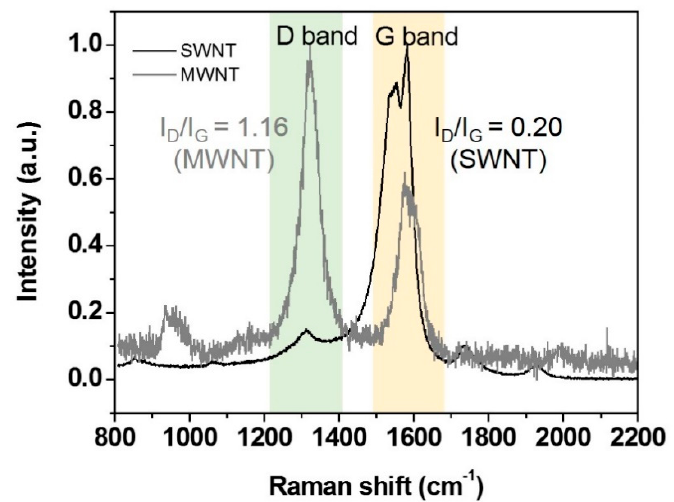
Figure 7. Comparison of Raman spectra between pristine SWNTs (black) and MWNTs (gray).